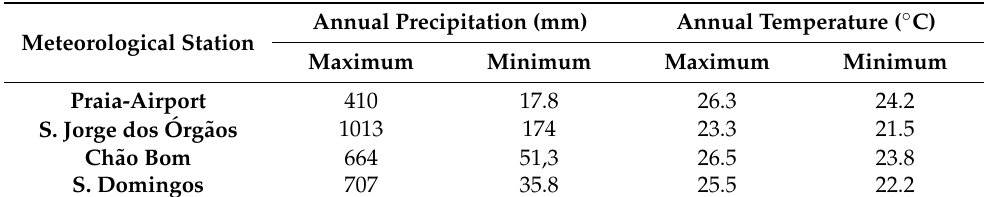
Table 1. Meteorological stations of Santiago Island with the precipitation and temperature maxi- mum (max) and minimum (min) values: precipitation is based on the temporal series 1990 to 2016; temperature is based on the series 1981 to 2016.